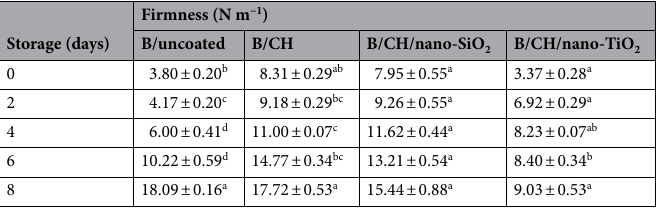
Table 1. Effects of coating treatments on firmness. * Values within a column (lowercase) are significantly different ( p ≥ 0.05). The values in parentheses indicate (SD ±) standard